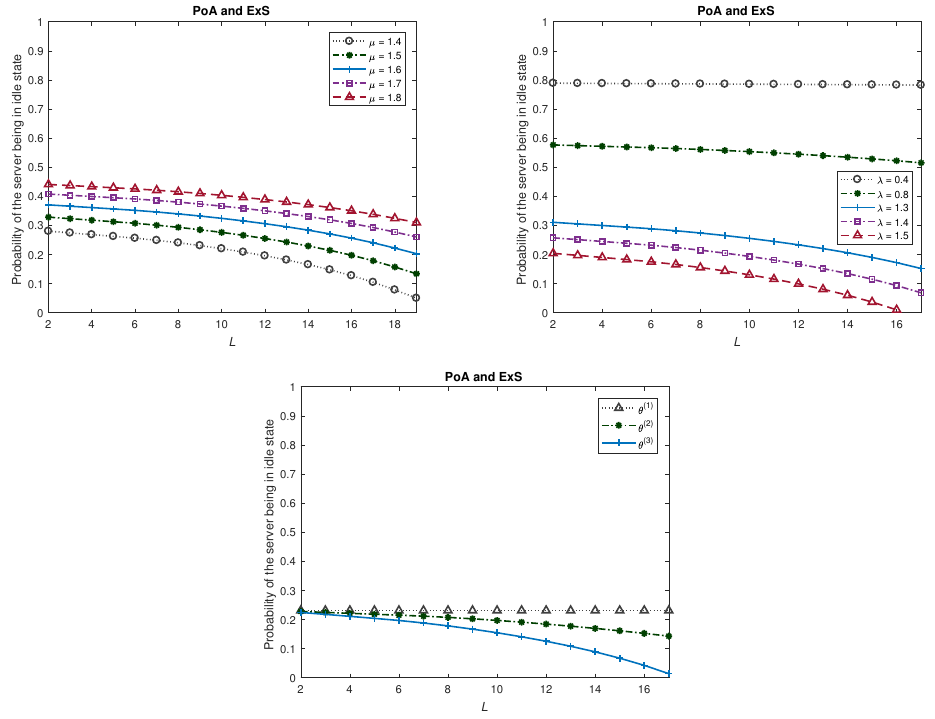
Figure 3. Probability of the server being in idle state (Model